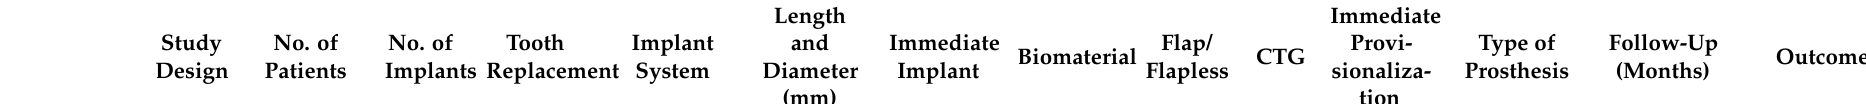
Table 1. Characteristics of the studies included in the systematic review. Caption: n = number, CTG = connective tissue